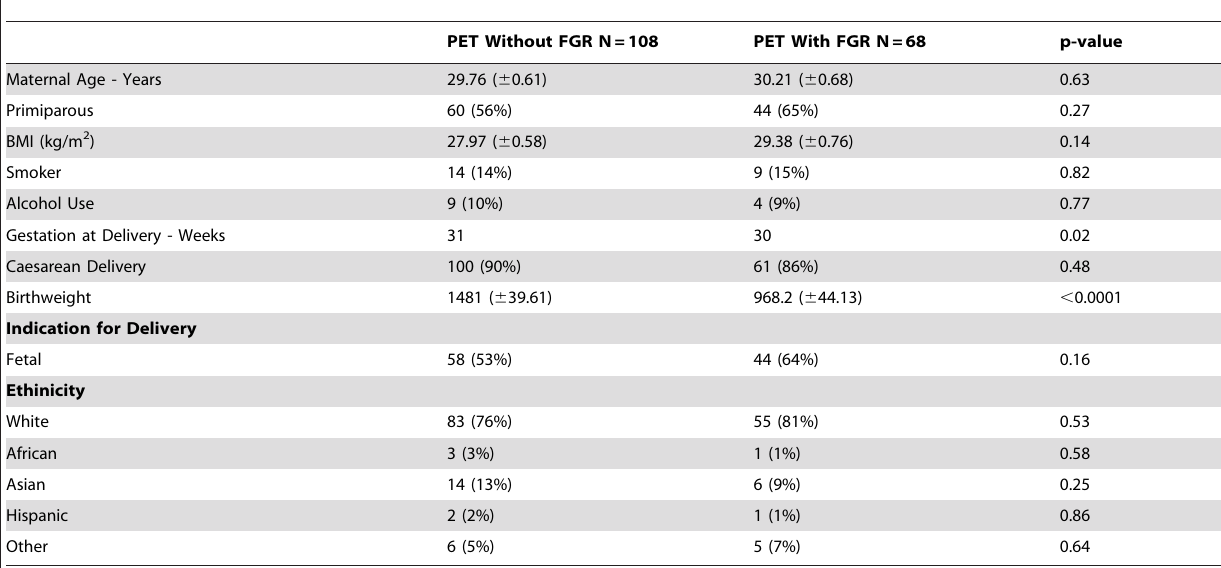
Table 1. Baseline Characteristics of women with pre-eclampsia with or without fetal growth restriction.